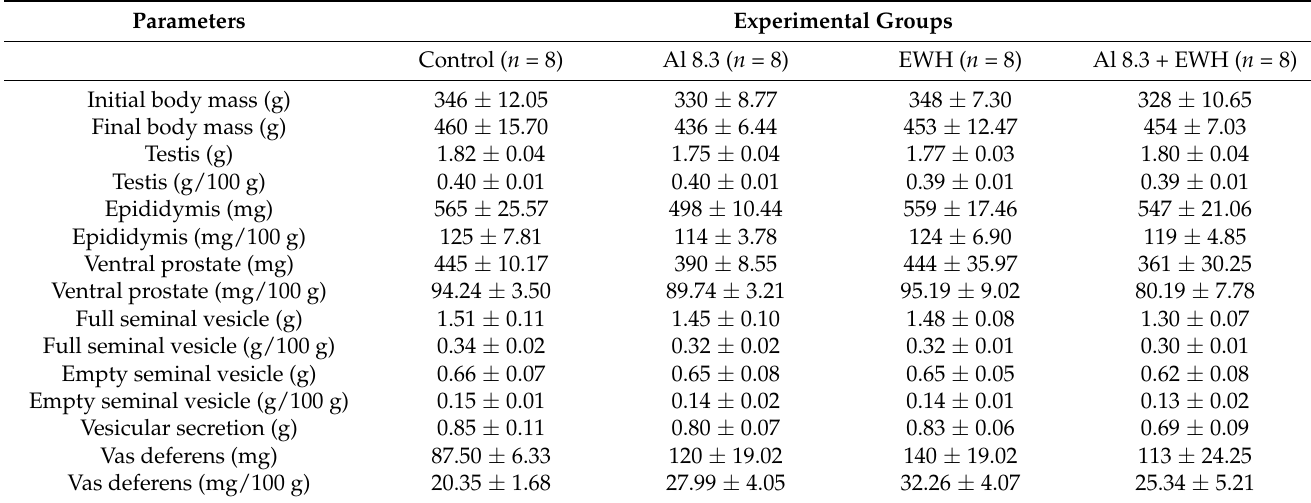
Table 1. Effect of EWH on body mass (g), absolute (g or mg) and relative (g/100 g or mg/100 g) mass of reproductive organs of male rats exposed to AlCl 3 at 8.3 mg/kg for 60 days.